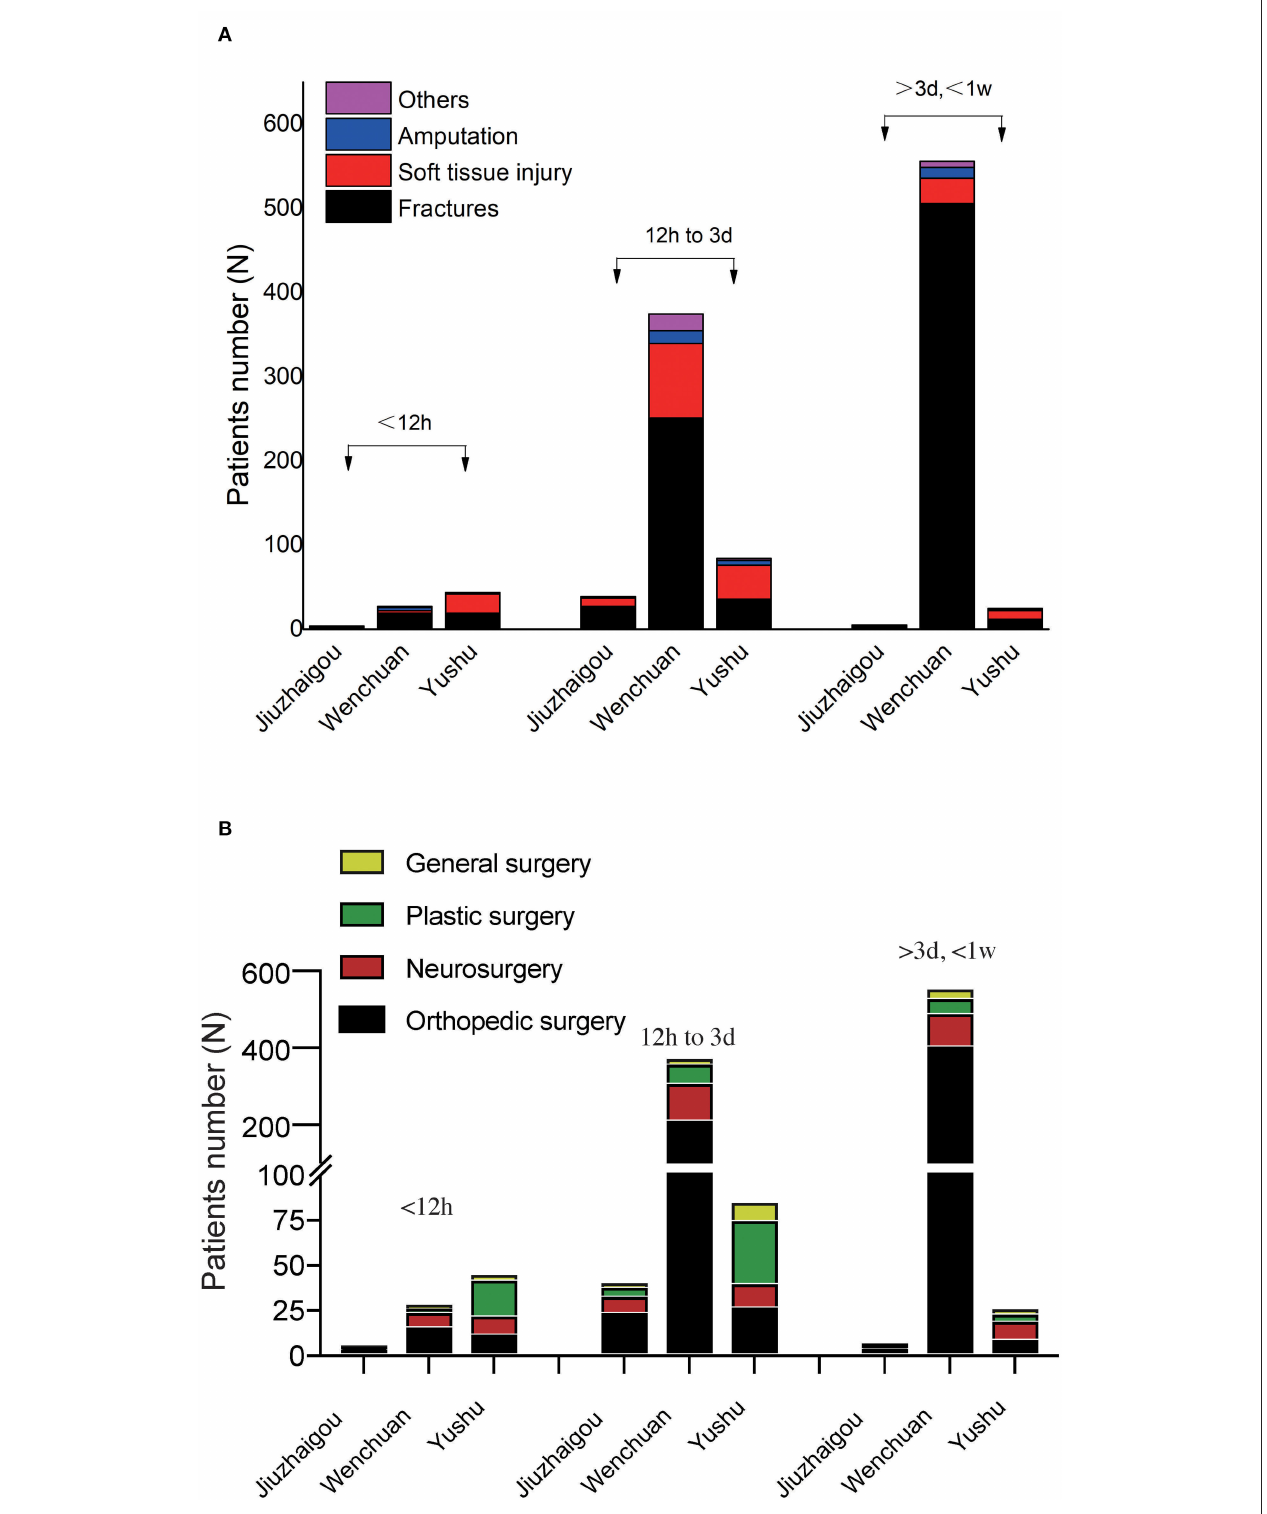
FIGURE 3 | The time of the different injury types and surgical treatment in Jiuzhaigou, Whenchuan and Yushu earthquake patients. (A) The time of the different injury types in different earthquake patients. (B) The time of the different surgical treatment in different earthquake patients.